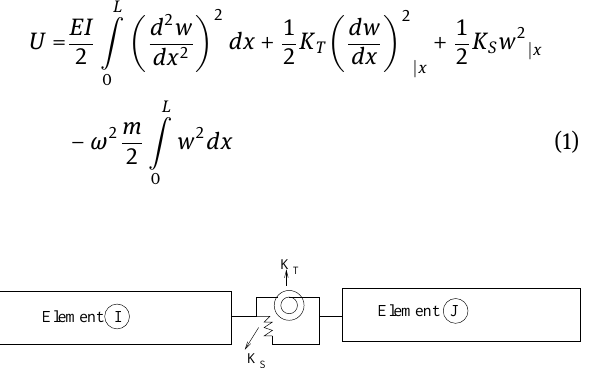
Fig. 1. Modelling of a typical flexible joint ( K T is the rotational spring stiffness and K S is the shear stiffness of the joint) between elements I and